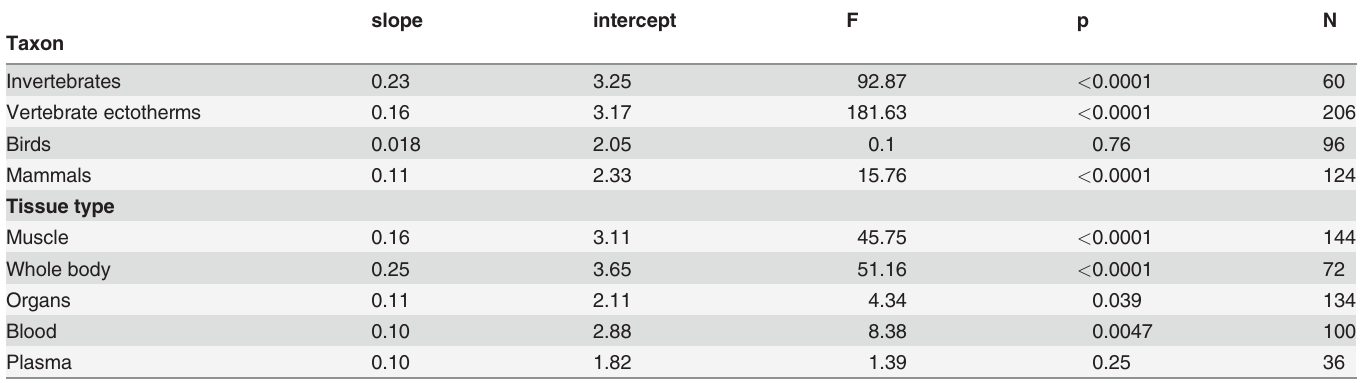
Table 1. Regression coef fi cients of relationships between ln(animal body mass, g) and ln(isotopic half-life, days) for each taxon and tissue type included in this study.